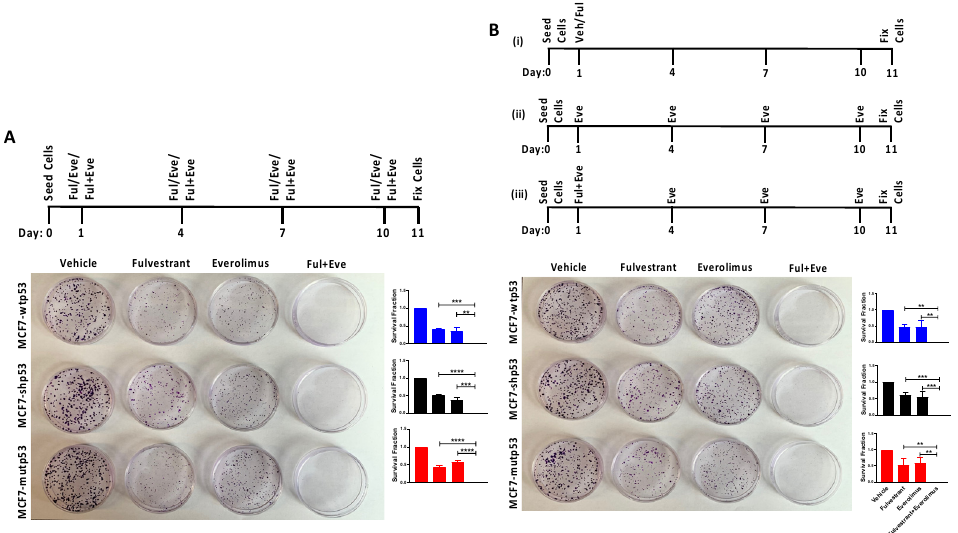
Figure 4. Effect of different modes of combining Fulvestrant and Everolimus on the clonogenic survival of MCF7 isogenic cell lines. ( A ) Mono- or combination-therapy with multiple doses of Fulvestrant and Everolimus. The schematic of the treatment is shown on the top. MCF7 isogenic cells differing in their p53 mutational status (MCF-wtp53, MCF7-shp53, and MCF7-mutp53) were seeded at low density on day 0. Cells were then treated with Fulvestrant (0.92 nM) and Everolimus (20 nM) as mono- or combined therapy 24 h post-seeding (day 1) and subsequently both drugs were replenished every 72 h (days 4, 7, and 10). Cells were then fixed 11 days post-seeding, and colonies were counted for further analysis. The effect of the drug treatment on surviving colonies is pictorially and graphically represented. Values reflect mean ± standard deviation of three biological replicates. ** p -value < 0.01 *** p -value < 0.001 and **** p -value < 0.0001 demonstrate statistical significance by One-way ANOVA. Ful: Fulvestrant, Eve: Everolimus. ( B ) Determining the effect of multiple-dose treatment of Everolimus added to a single dose of Fulvestrant. The treatment schematic is shown on the top panel. MCF7 isogenic cells differing in their p53 mutational status, were seeded at low density on day 0. Cells were then treated with Fulvestrant (0.92 nM) and Everolimus (20 nM) as monotherapy or combination therapy 24 h post seeding on day 1 (i, ii, and iii, respectively). Given the short half-life of the drug, Everolimus was added every 72 h (days 4, 7, and 10) to the Everolimus monotherapy arm (i) and to the combination therapy arm (iii), while Fulvestrant was added only once (day 1) in Fulvestrant monotherapy and in the combination therapy arms, as shown in the schematic (i, iii). Cells were then fixed 11 days post-seeding, and colonies were counted for further analysis. The effect of the drug treatment on surviving colonies is pictorially and graphically represented. This dosing scheme closely mimics the treatment of the two drugs in the clinic, where Fulvestrant is given once every 28 days and Everolimus is given daily. Values reflect mean ± standard deviation of three biological replicates. ** p -value < 0.01, *** p -value < 0.001 demonstrate statistical significance